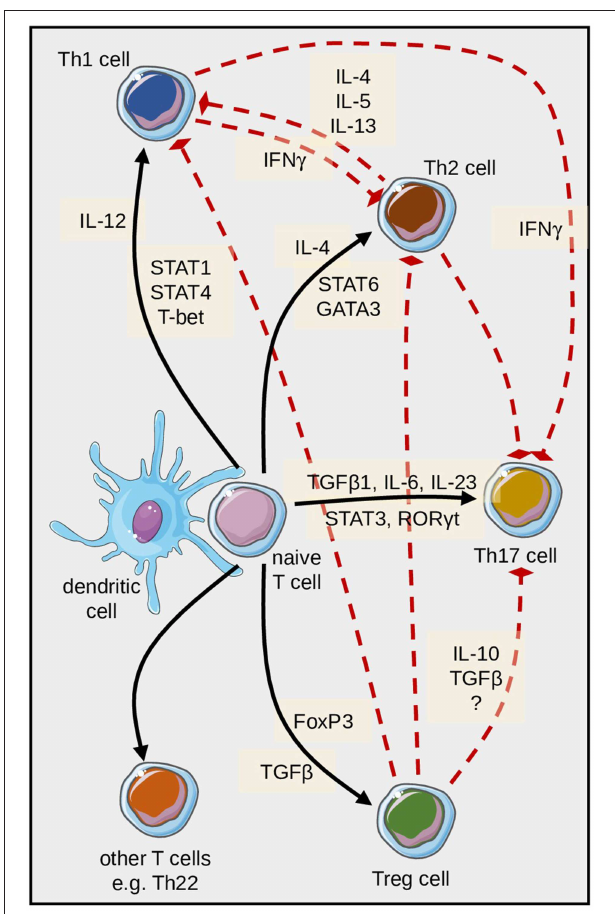
FIGURE 3 | Differentiation of pathogenic T cells in psoriasis is embedded in a complex regulatory network. Naïve T cells can differentiate into several directions; this is mainly determined by the cytokines and transcription factors depicted here. In addition, various regulatory feedback mechanisms exist, some of which are schematically highlighted here with particular reference to Th17 cell differentiation and